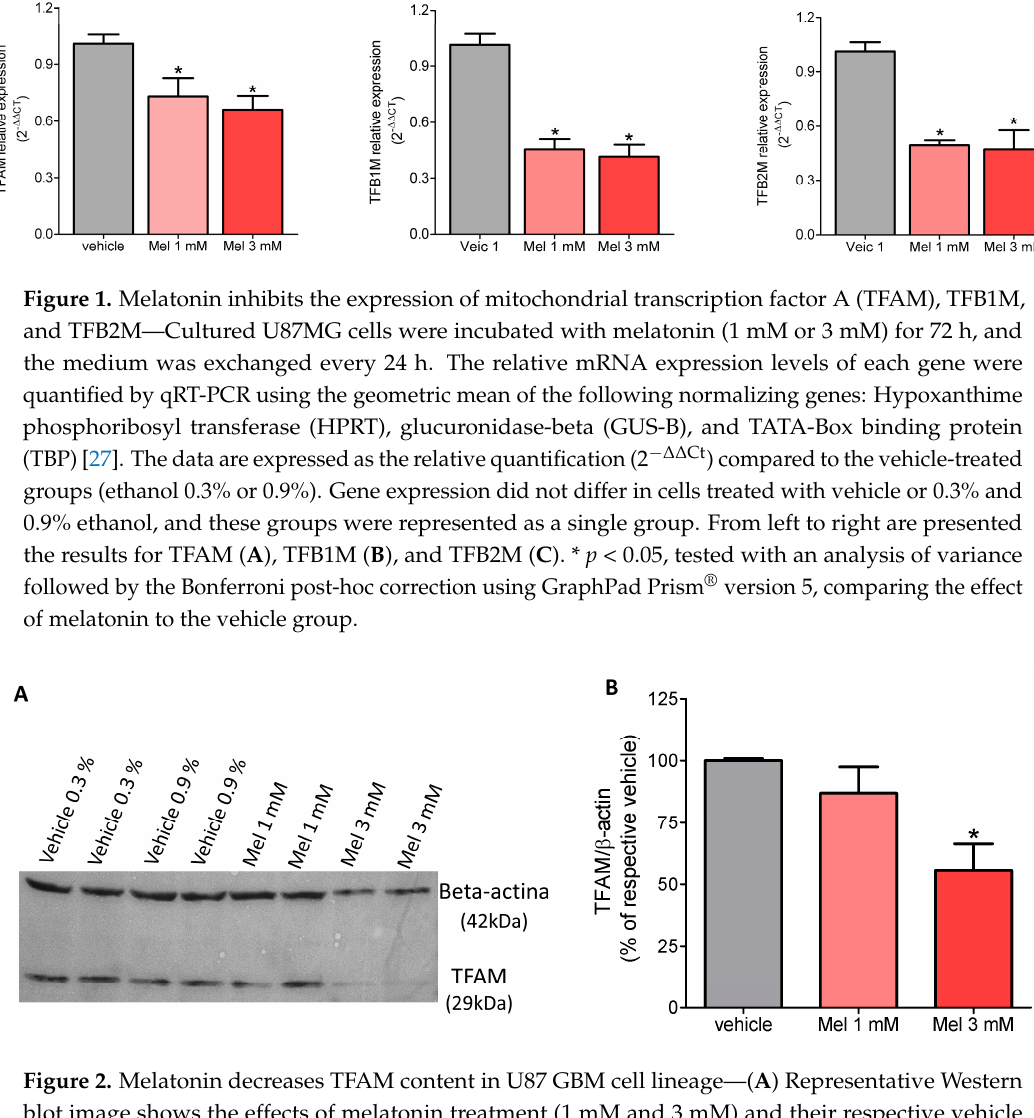
Figure 2. Melatonin decreases TFAM content in U87 GBM cell lineage—( A ) Representative Western blot image shows the effects of melatonin treatment (1 mM and 3 mM) and their respective vehicle groups (ethanol 0.3% and 0.9%) on the protein TFAM expression. ( B ) The bar graph shows quantitative signal intensities of the protein TFAM expression after normalization with β -actina. TFAM protein cell content did not differ in cells treated with vehicles and these groups were represented as a single bar. * p > 0.05 compared to vehicle. The statistical analysis consisted of an ANOVA followed by Bonferroni’s post-hoc test.